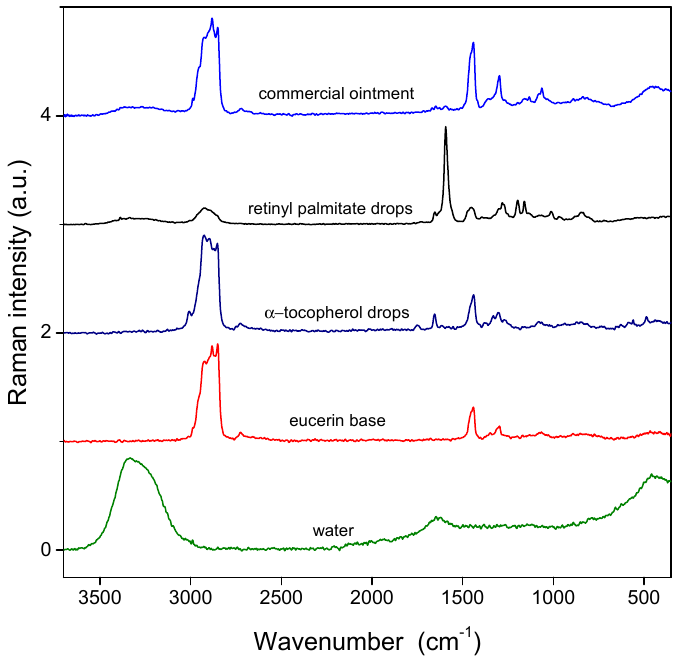
Figure 2. Raman spectra of commercial ointment, vitamin A and vitamin E drops, eucerin base and water; spectra were shifted for clarity.